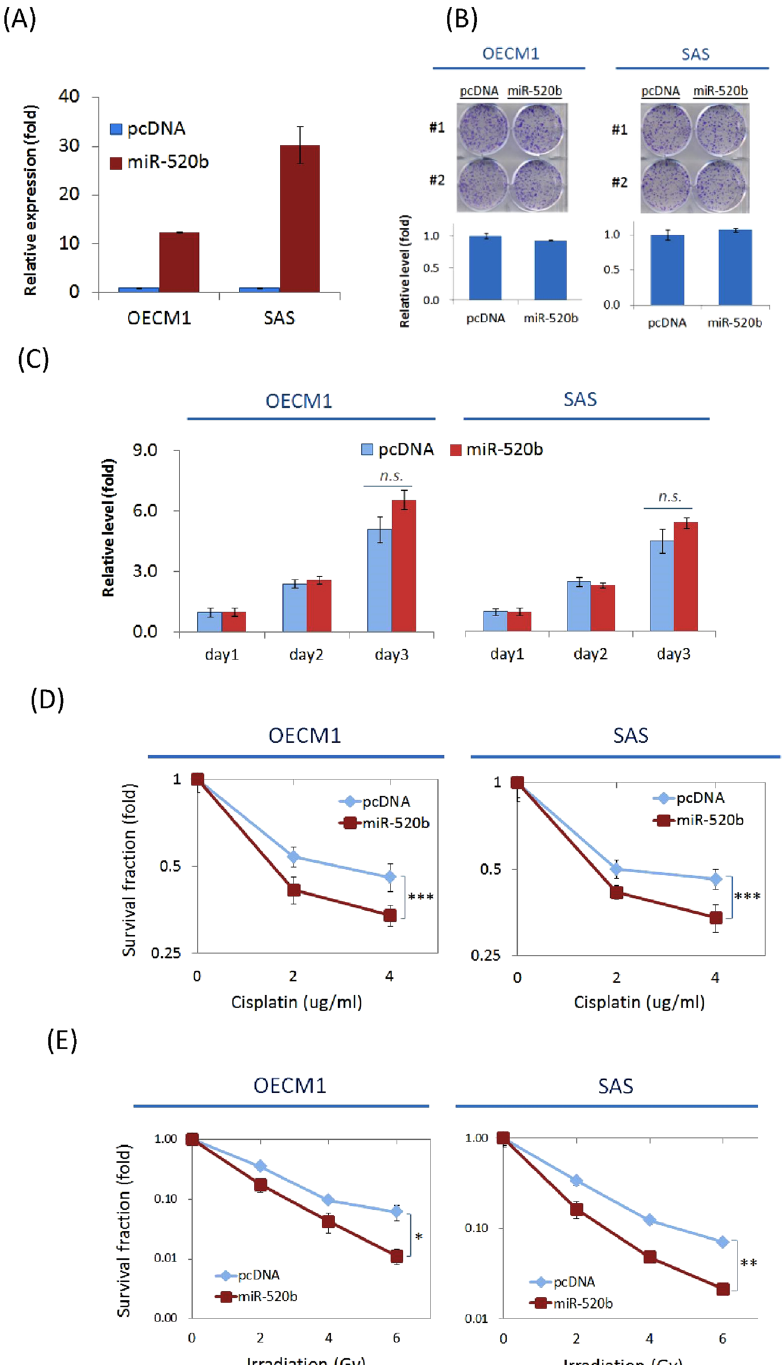
Figure 2. MiR-520b sensitizes cells to chemotherapy drugs and irradiation, while minimal effect on cell growth. ( A ) Cells were transfected with the miR-520b over-expression plasmid (miR-520b) or the vector (pcDNA) and were cultured for 1 day. The miR-520b expression levels were determined. ( B ) The effects of miR- 520b modulation on colony formation. A total of 1 × 10 5 cells were seeded in 6-well plates for 7 days to allow cell colony formation. The number of colonies was then counted. ( C ) The effects of miR-520b modulation on cell growth. A total of 1 × 10 6 cells were re-seeded in 100-mm plates and the cell numbers were determined daily up to 3 days. ( D ) To detect the chemosensitivity of the cells, the relative number of surviving cells was determined after treatment with various doses of cisplatin (0 to 4 μ g/ml) for 2 days. ( E ) To determine radiosensitivity, the colony survival fractions were determined after the cells were irradiated with various doses (0 to 6 Gy). All the experiments were performed duplicate for three times, and the similar results were obtained. The error bars shown in the relevant figures indicated the standard deviation of the three independent experiments. ( * p < 0.05, ** p < 0.01, *** p < 0.001, n.s .: non-significance, t